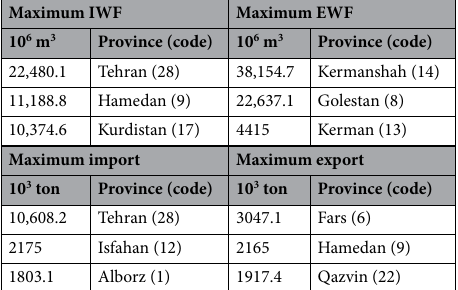
Table 2. Main water footprint exports and imports compared with the amounts of exchanged crops.